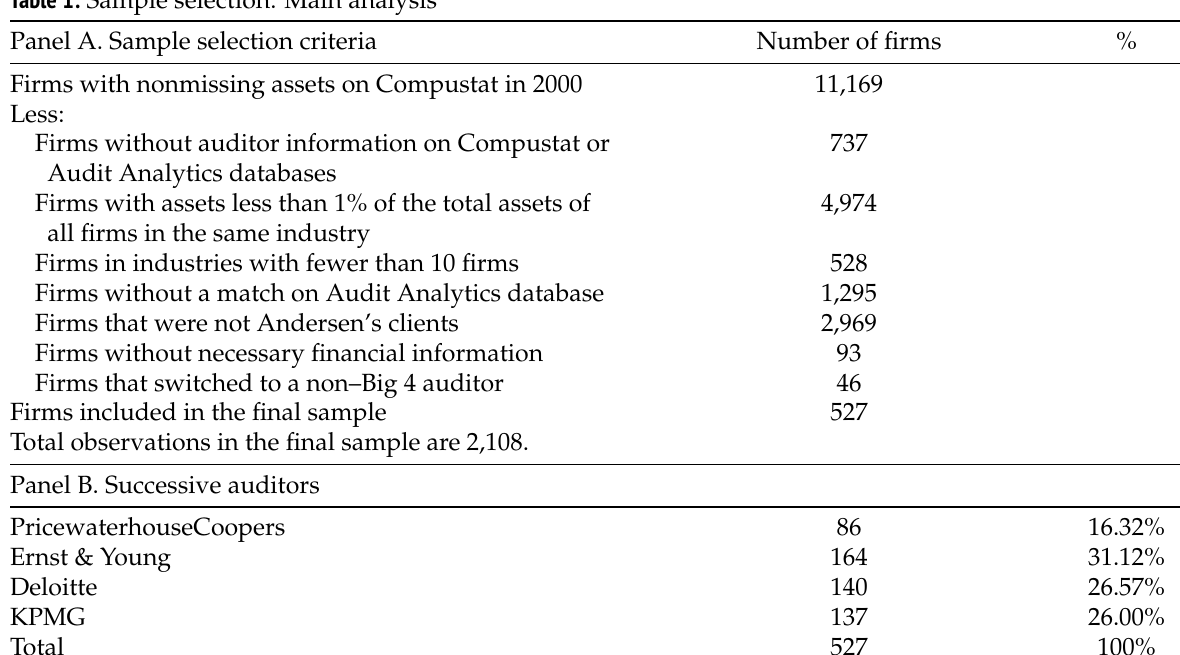
Table 1: Sample selection: Main analysis Panel A. Sample selection